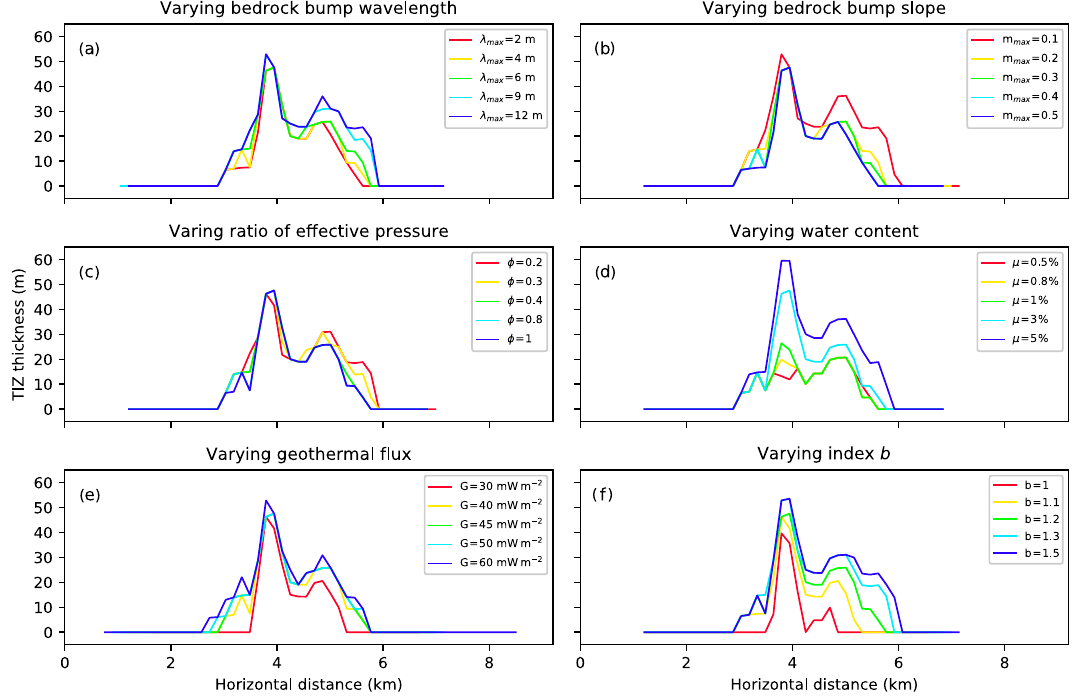
Figure 6. Sensitivity of modelled temperate ice thicknesses to parameters along the CL. The parameter settings are the same as described in Fig.